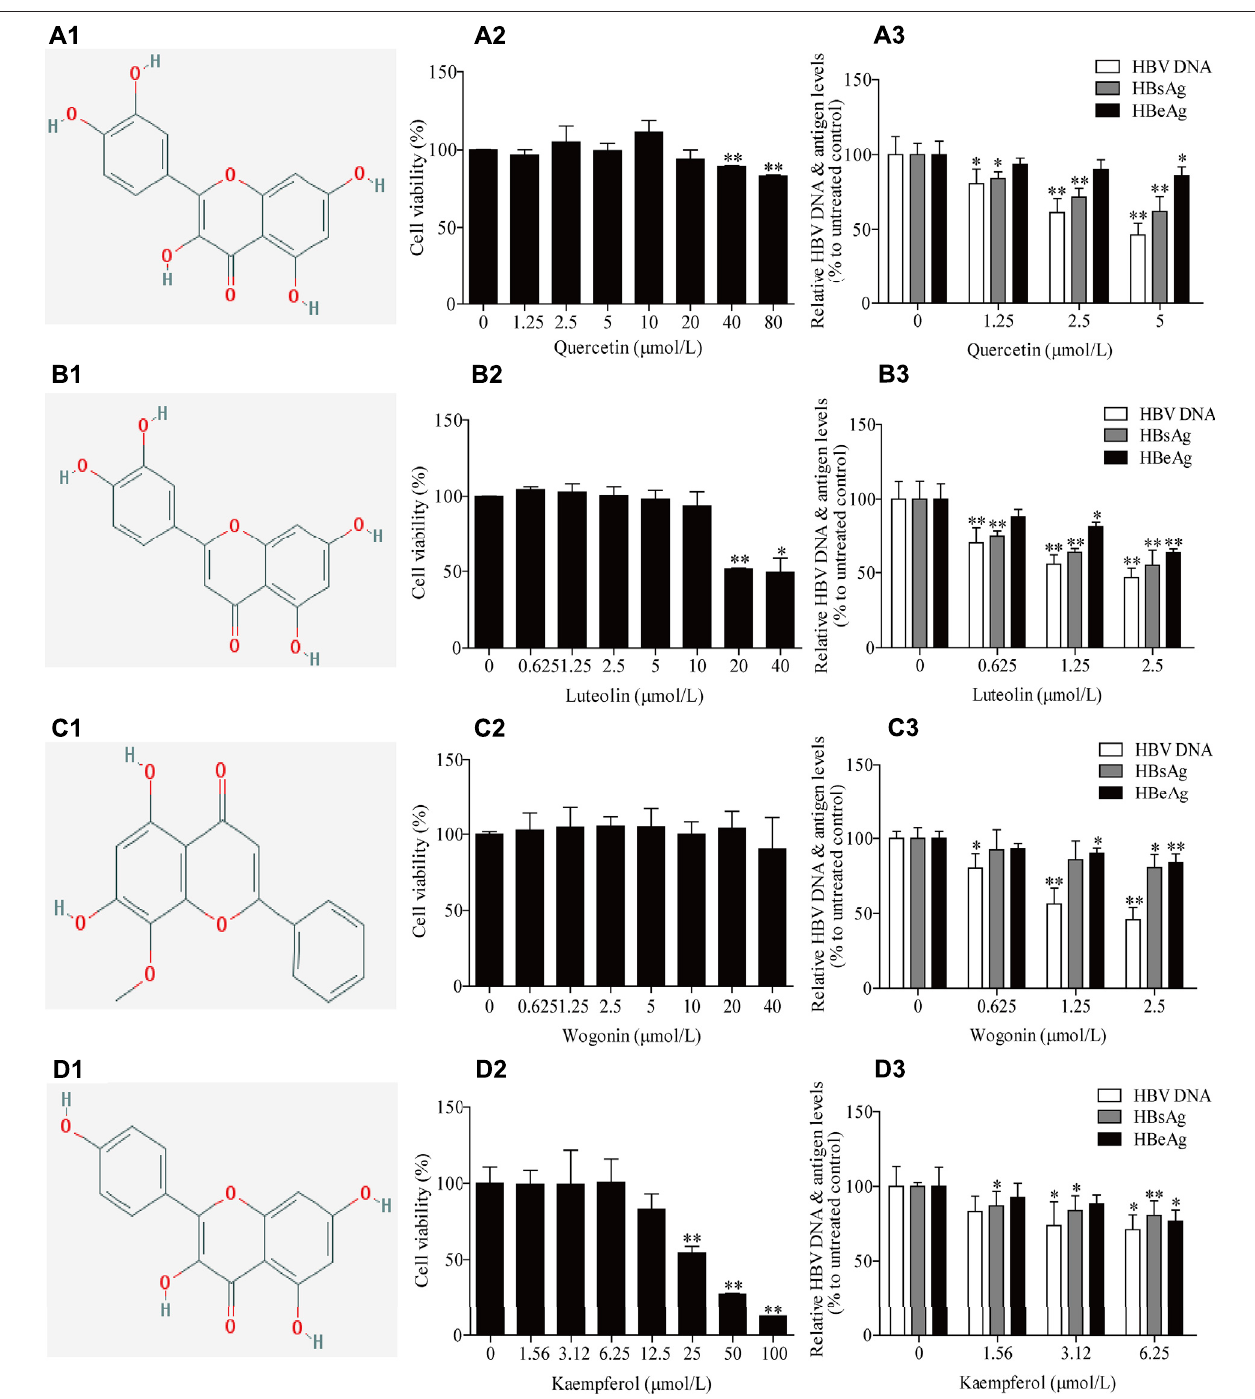
FIGURE 8 | The inhibitory effects of four active compounds in LWWL on HBV DNA and antigens in cell models. The chemical structure of (A1) quercetin, (B1) luteolin, (C1) wogonin and (D1) kaempferol. Evaluation of safe concentration of (A2) quercetin, (B2) luteolin, (C2) wogonin, and (D2) kaempferol in HepG2.2.15 cells. The inhibitory effectsof (A3) quercetin, (B3) luteolin, (C3) wogonin, and (D3) kaempferolon on HBV DNA, and supernatant HBsAg and HBeAg were observed inHepG2.2.15 cells. * and ** represent p < 0.05 and p < 0.01 respectively in difference comparison between resultant values treated with each indicated concentration of the tested compounds and the value treated with zero concentration of the tested compounds. LWWL, Liuweiwuling Tablet.